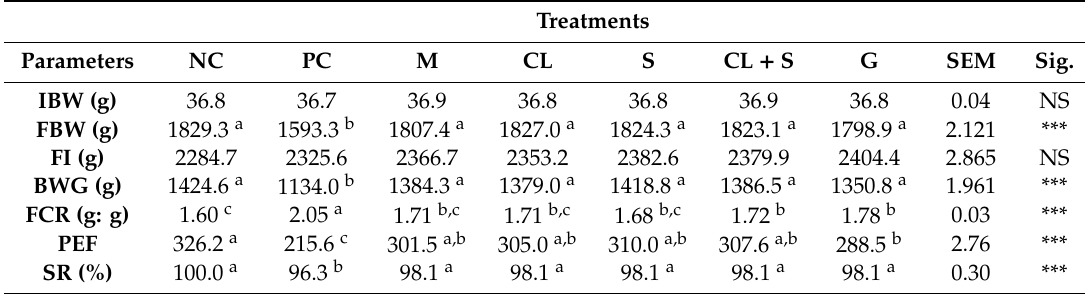
Table 3. E ff ect of probiotic diet supplementation on growth performance and feed e ffi ciency in broiler chicks challenged with C.